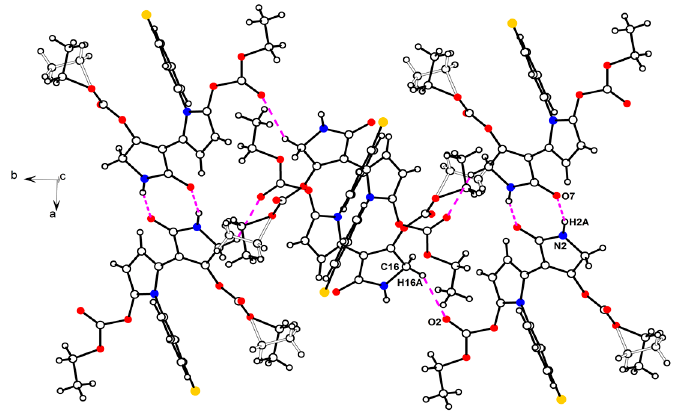
Figure 2. Two-dimensional structure of compound 6b with intermolecular hydrogen bonds.